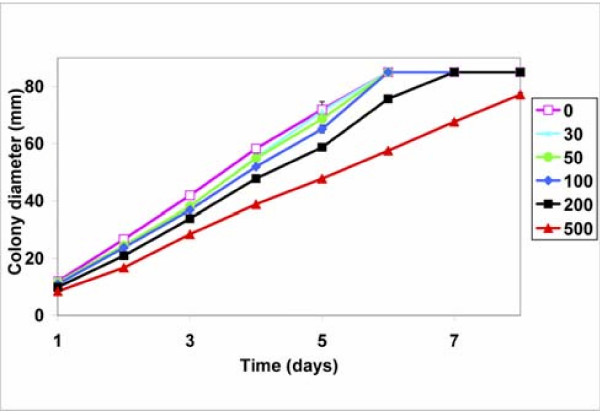
Sensitivity of A. fumigatus to doxycycline. Ten thousand conidia were spotted onto plates containing Aspergillus minimal medium and the indicated concentrations of doxycycline (μg/ml) and colony diameter was measured for 8 days at 37°C. This experiment used standard Aspergillus minimal medium adjusted to pH 6.5, but similar results were obtained when the pH was adjusted to 8 (data not shown).